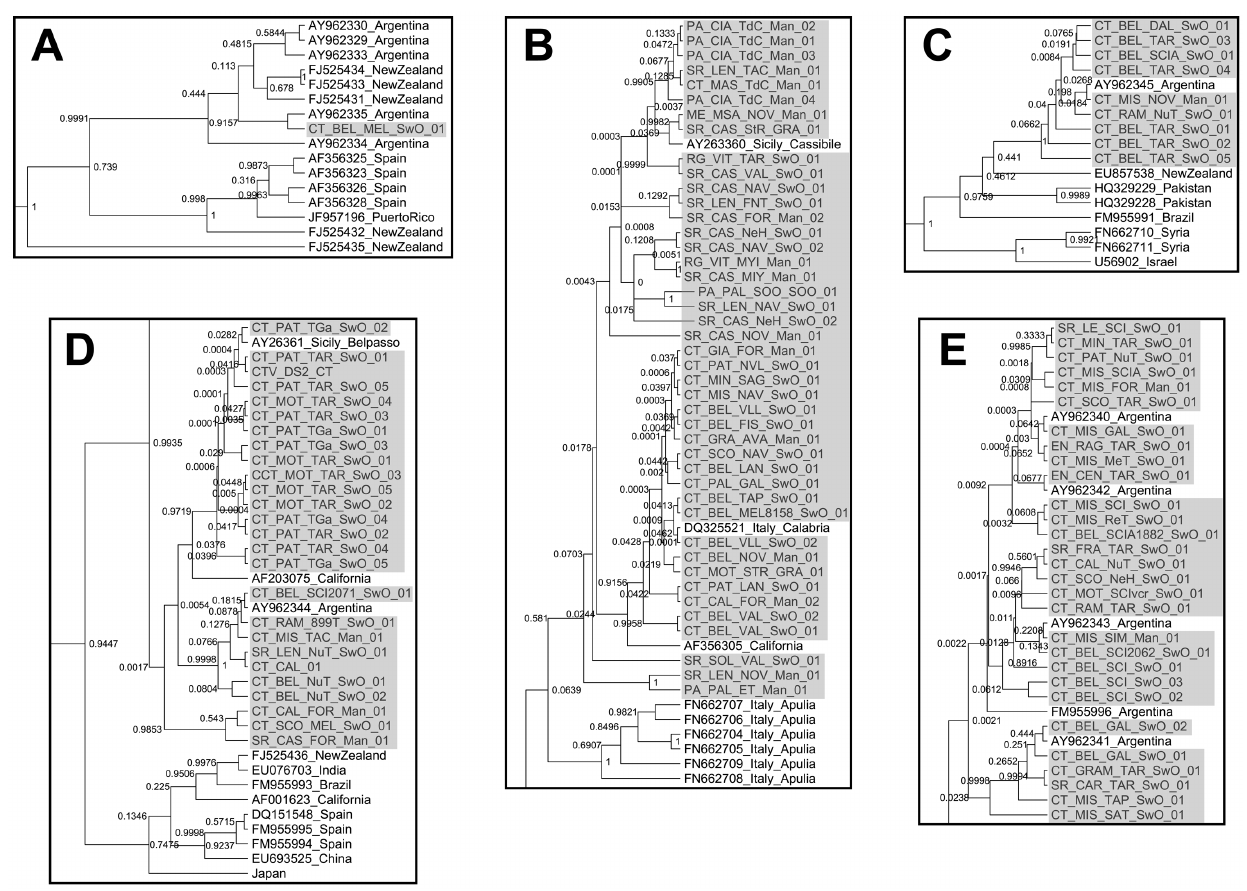
Figure 3. Parts of a Bayesian phylogenetic tree indicating the five clades (A, B, C, D, and E) containing CTV isolates from Sicily. Figure S1 shows all the clades; including also those without the Sicilian isolates. The sequences determined in this work are highlighted in grey background. Node significances are indicated by Bayesian posterior probabilities. doi:10.1371/journal.pone.0066700.g003 PLOS ONE |